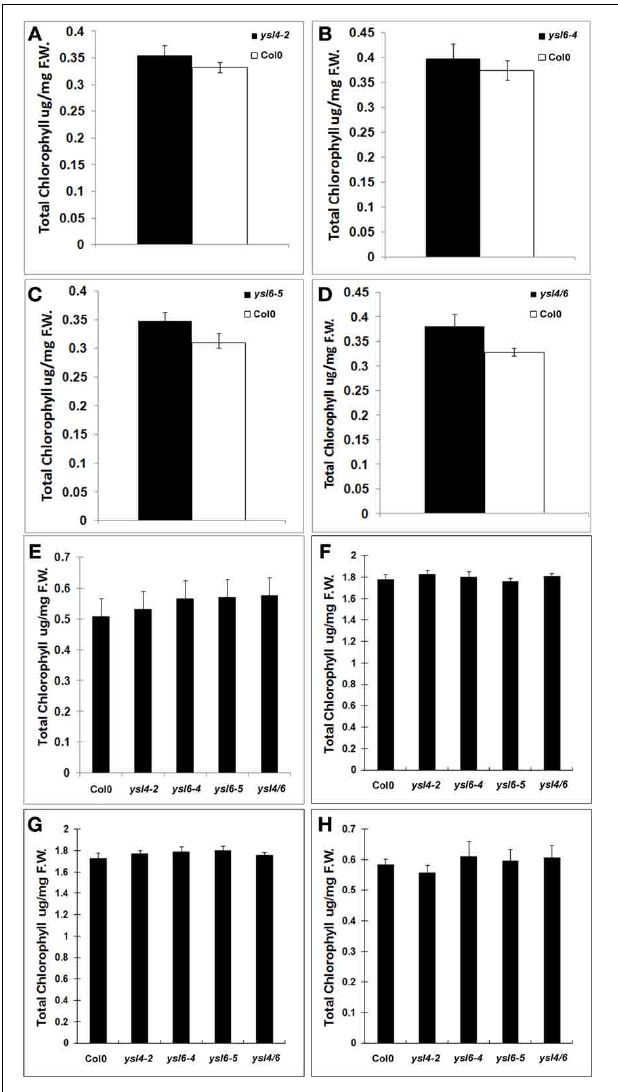
FIGURE 8 | Metal starvation response in seedlings of Col-0, ysl4-2, ysl6-4, ysl6-5, and ysl4ysl6. (A–D) Seedlings were grown on MS medium lacking Fe for 5 days and then chlorophyll levels were measured. (A) Chlorophyll levels of Col-0 and ysl4-2. (B) Chlorophyll levels of Col-0 and ysl6-4. (C) Chlorophyll levels of Col-0 and ysl6-5. (D) Chlorophyll levels of Col-0 and ysl4ysl6. (E–H) Plants were grown on MS plates for 10 days, and then transferred to MS without Fe, Zn, Cu, or Mn for 14 days. The total chlorophyll content of the shoot system was measured. (E)